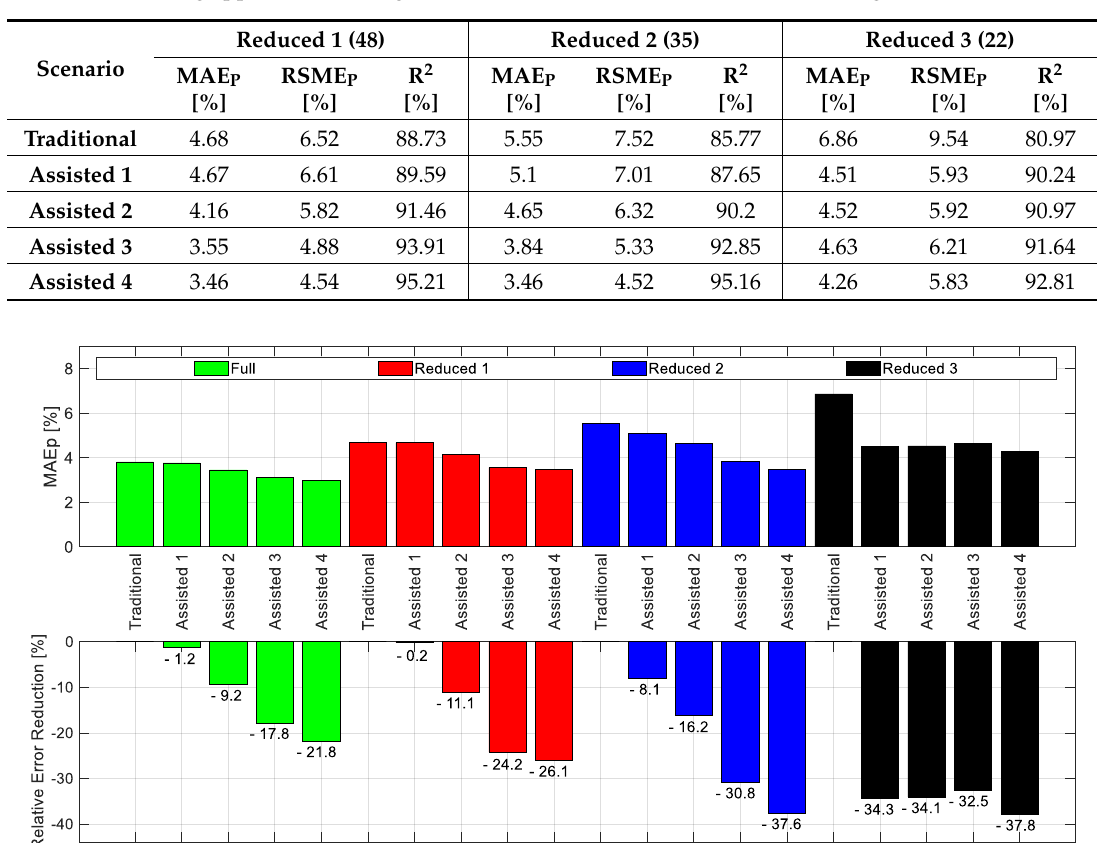
Figure 5. The effect of the assisted approach on the ANN prediction accuracy using the different learning algorithms. The MAE P values for the traditional and assisted approaches residual strength predictions ( top ), together with the error reduction of the assisted approach relative to the traditional approach ( bottom ). Averaged results for the 80 random combinations of the testing dataset.